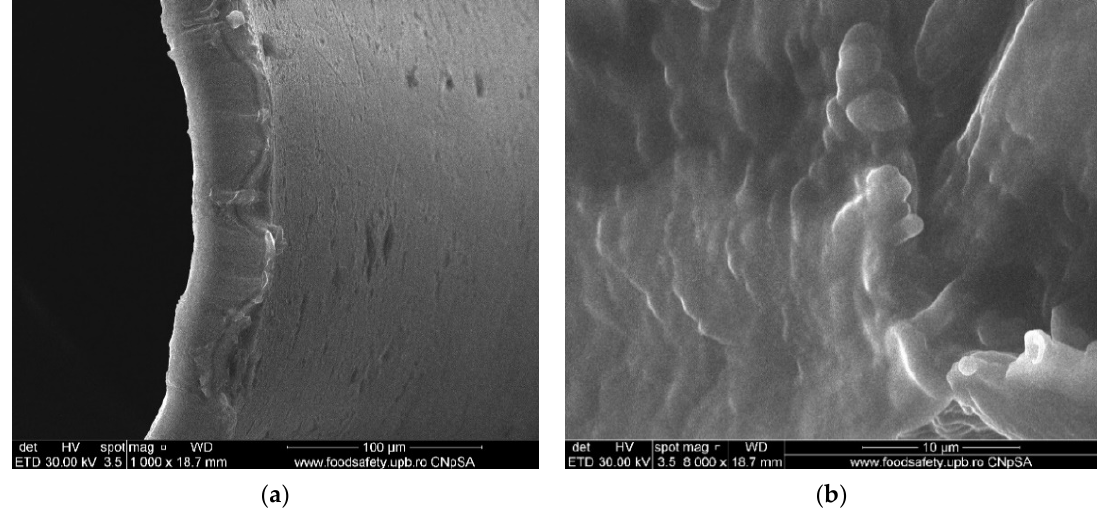
Figure 9. Morphology HEC–PPM membranes: ( a ) membrane cross–section; ( b ) membrane surface.